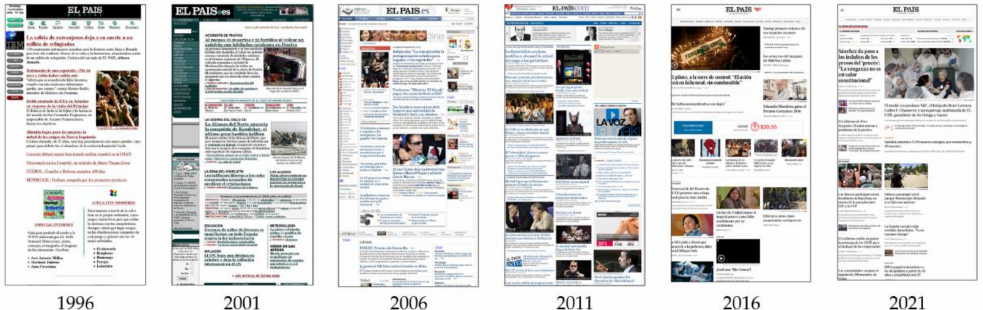
Figure 4. Evolution of El Pa í s homepage. Compiled by the